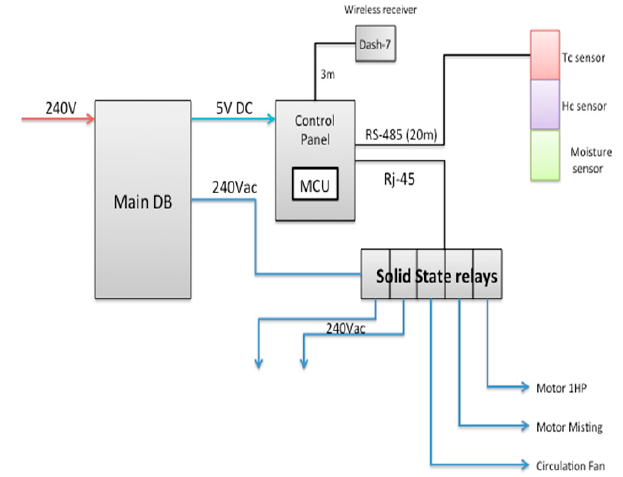
Figure 4. The control and feedback block diagram.